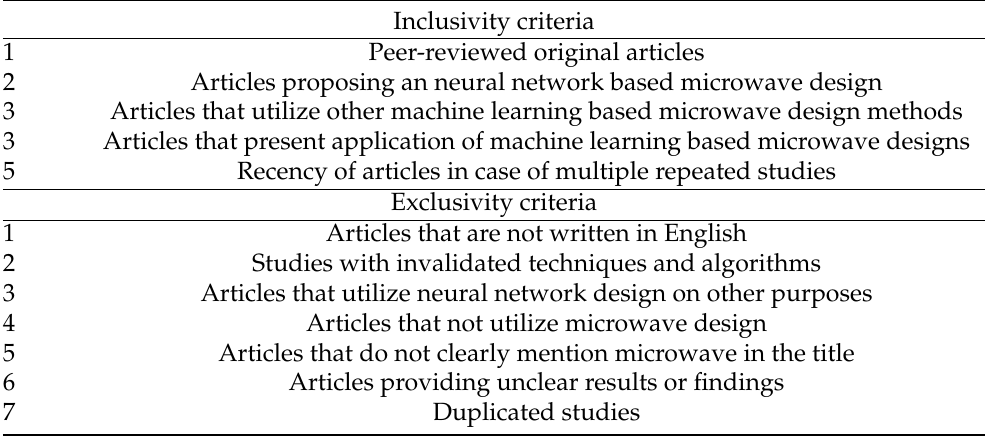
Table 2. Inclusion and exclusion